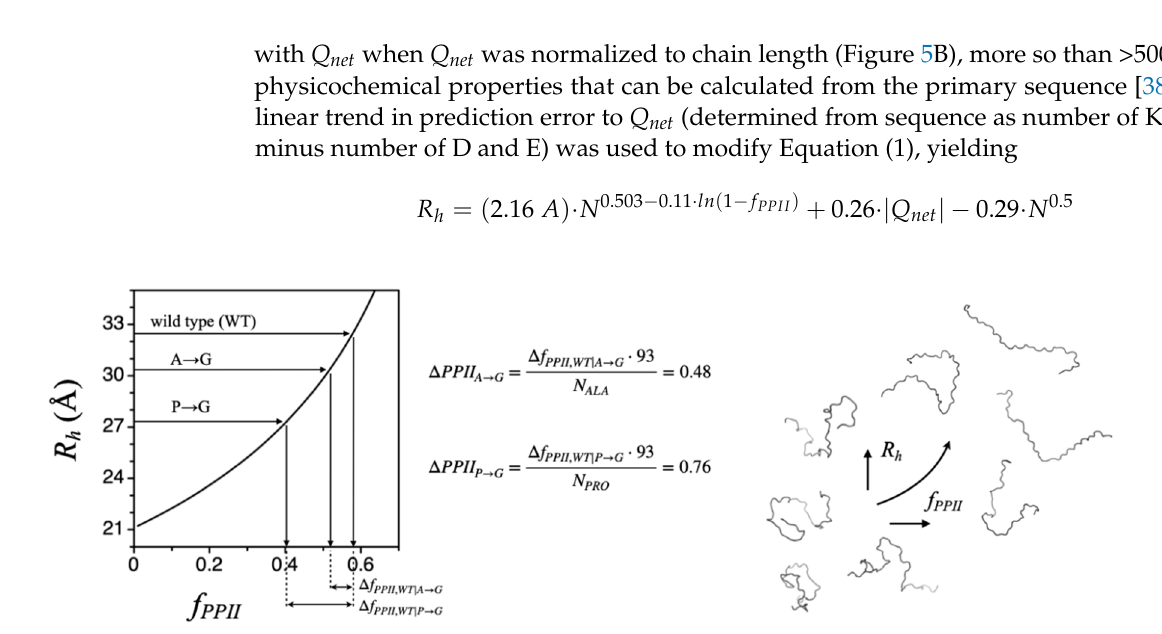
Figure 4. Using mutational effects on IDP R h to estimate changes in chain bias for PPII. Computed R h dependence on f PPII for a 93-residue polypeptide, using Equation (1). Arrows show results from experimental R h measured by both dynamic light scattering (DLS) and size exclusion chromatography (SEC) methods for wild type p53(1-93) and the P → G and A → G substitution mutants. In total, 22 proline ( N PRO ) and 12 alanine residues ( N ALA ) in the wild type sequence were substituted to glycine in the P → G and A → G mutants, respectively.